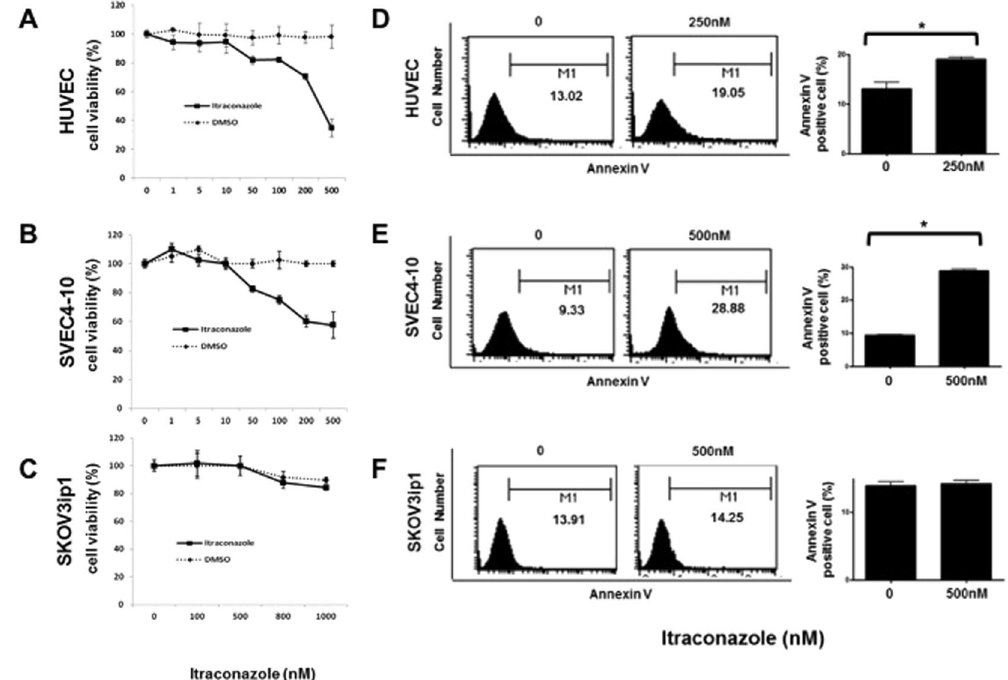
Figure 1. Inhibition of endothelial cell proliferation following treatment with itraconazole. Itraconazole inhibited cell proliferation in a dose-dependent manner, as evaluated by the MTT assay in HUVEC ( A ) and SVEC4-10 ( B ) cells. Proliferation of SKOV3 cells was not inhibited ( C ). Flow cytometric determination of apoptosis yielded similar results ( D–F ). The significance of differences was determined by unpaired t-test, and values of P < 0.05 ( * ) or P < 0.01 ( ** ) were considered to be statistically